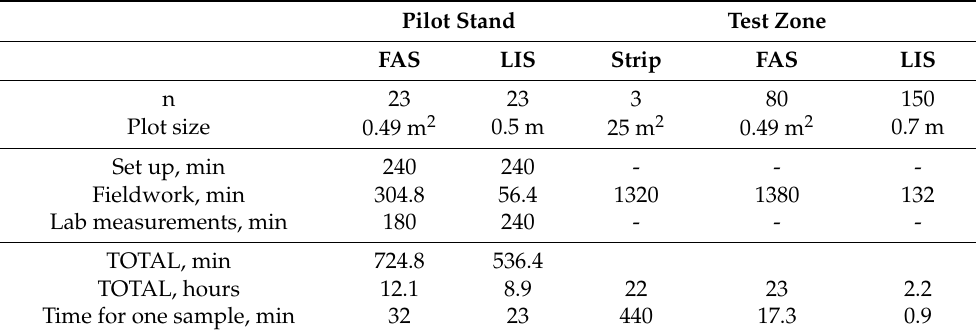
Table 2. Details of the time spent sampling and measuring fine woody debris (FWD) according to the fixed-area sampling (FAS) and line-intersect sampling (LIS) methods, on a one-person basis in the Pilot Stand (n = 23 plots over the area) and the Test